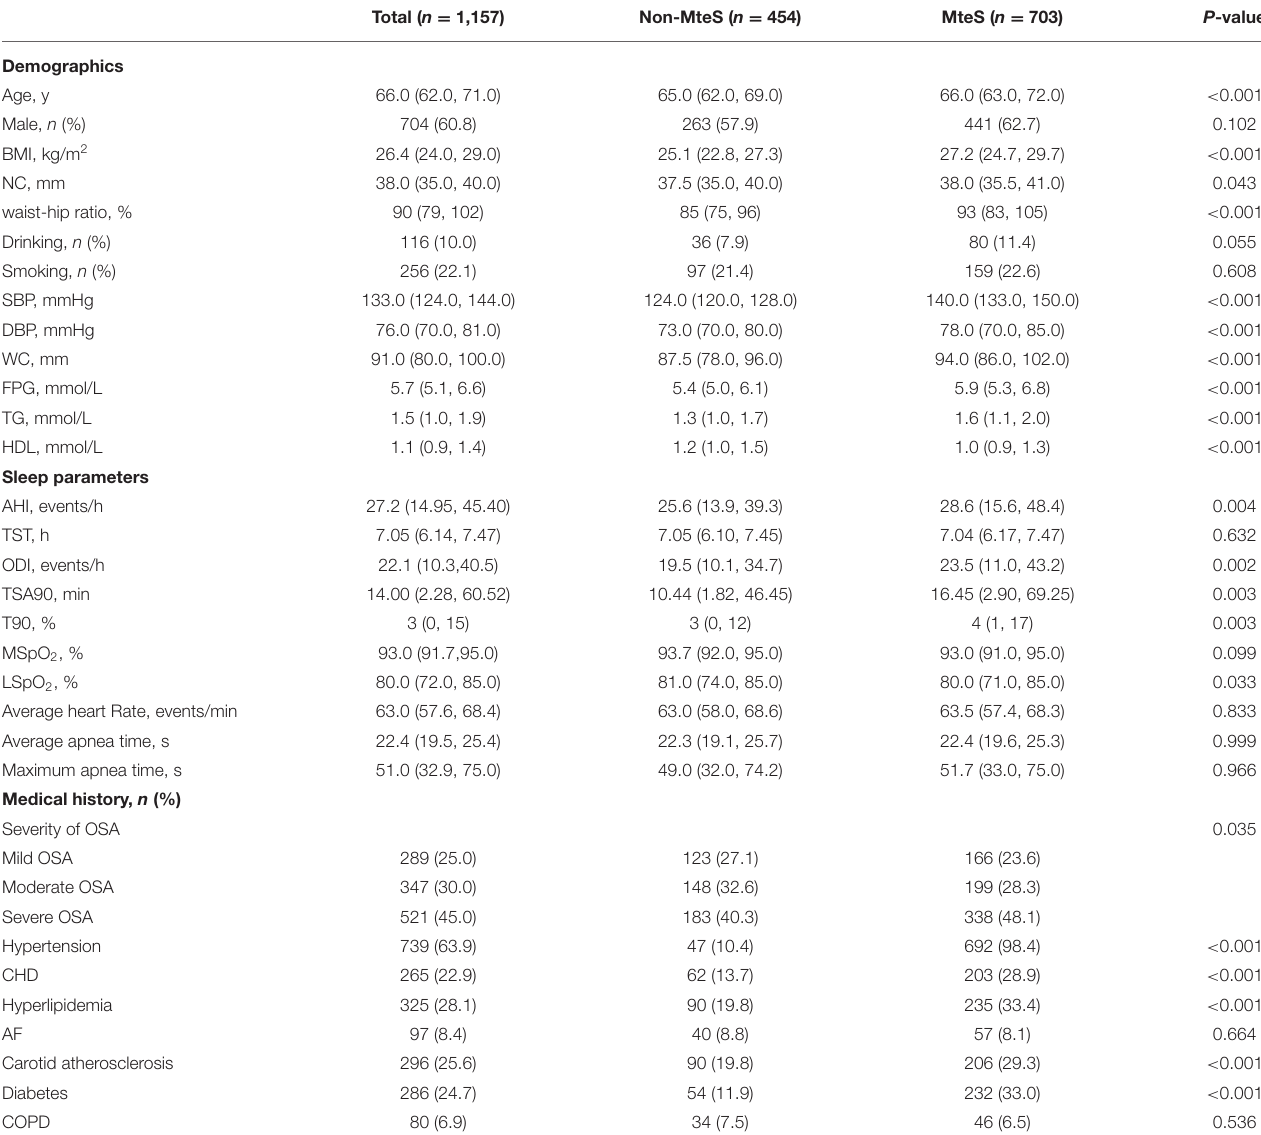
TABLE 1 | General characteristics of study subjects according to